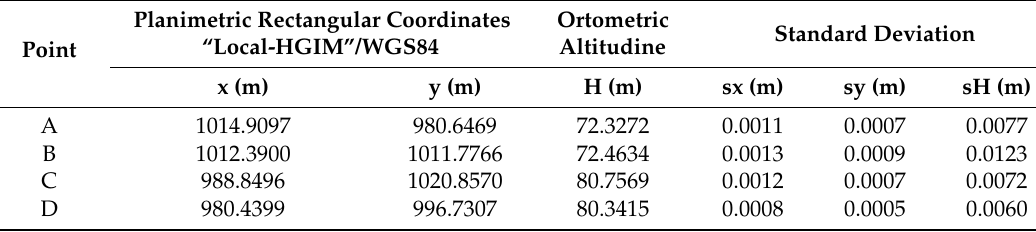
Table A2. The adjusted coordinates of GNSS network points in CRS—“LOCAL